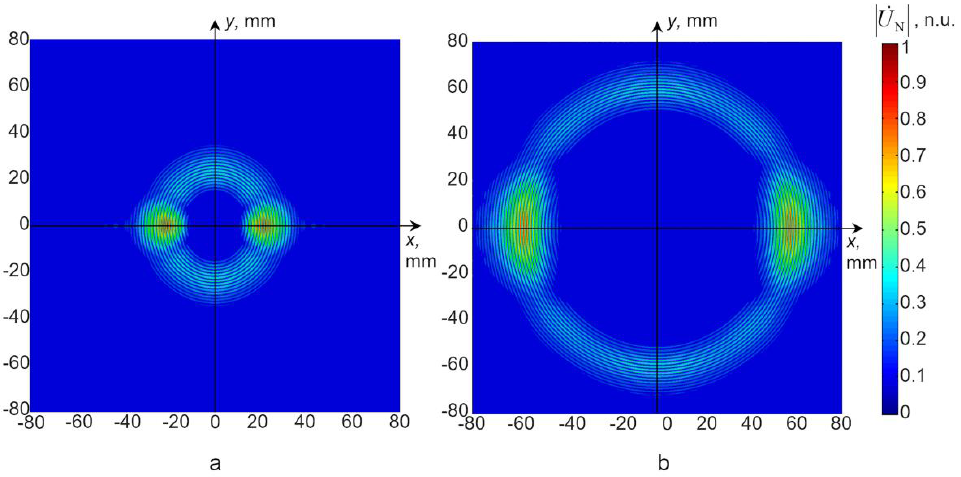
Figure 4. Dependence of spectrum amplitude at 44 kHz on the distance from the point type 1 × 1 mm 2 excitation point. Solid line—finite element modelling data, dashed line—curve fitting.